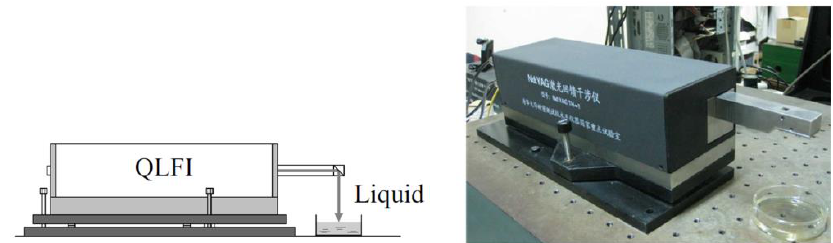
Figure 12. Quasi-common-path laser feedback interferometer (QLFI) monitoring the liquid level. (Figure reproduced from Ref. [66]).